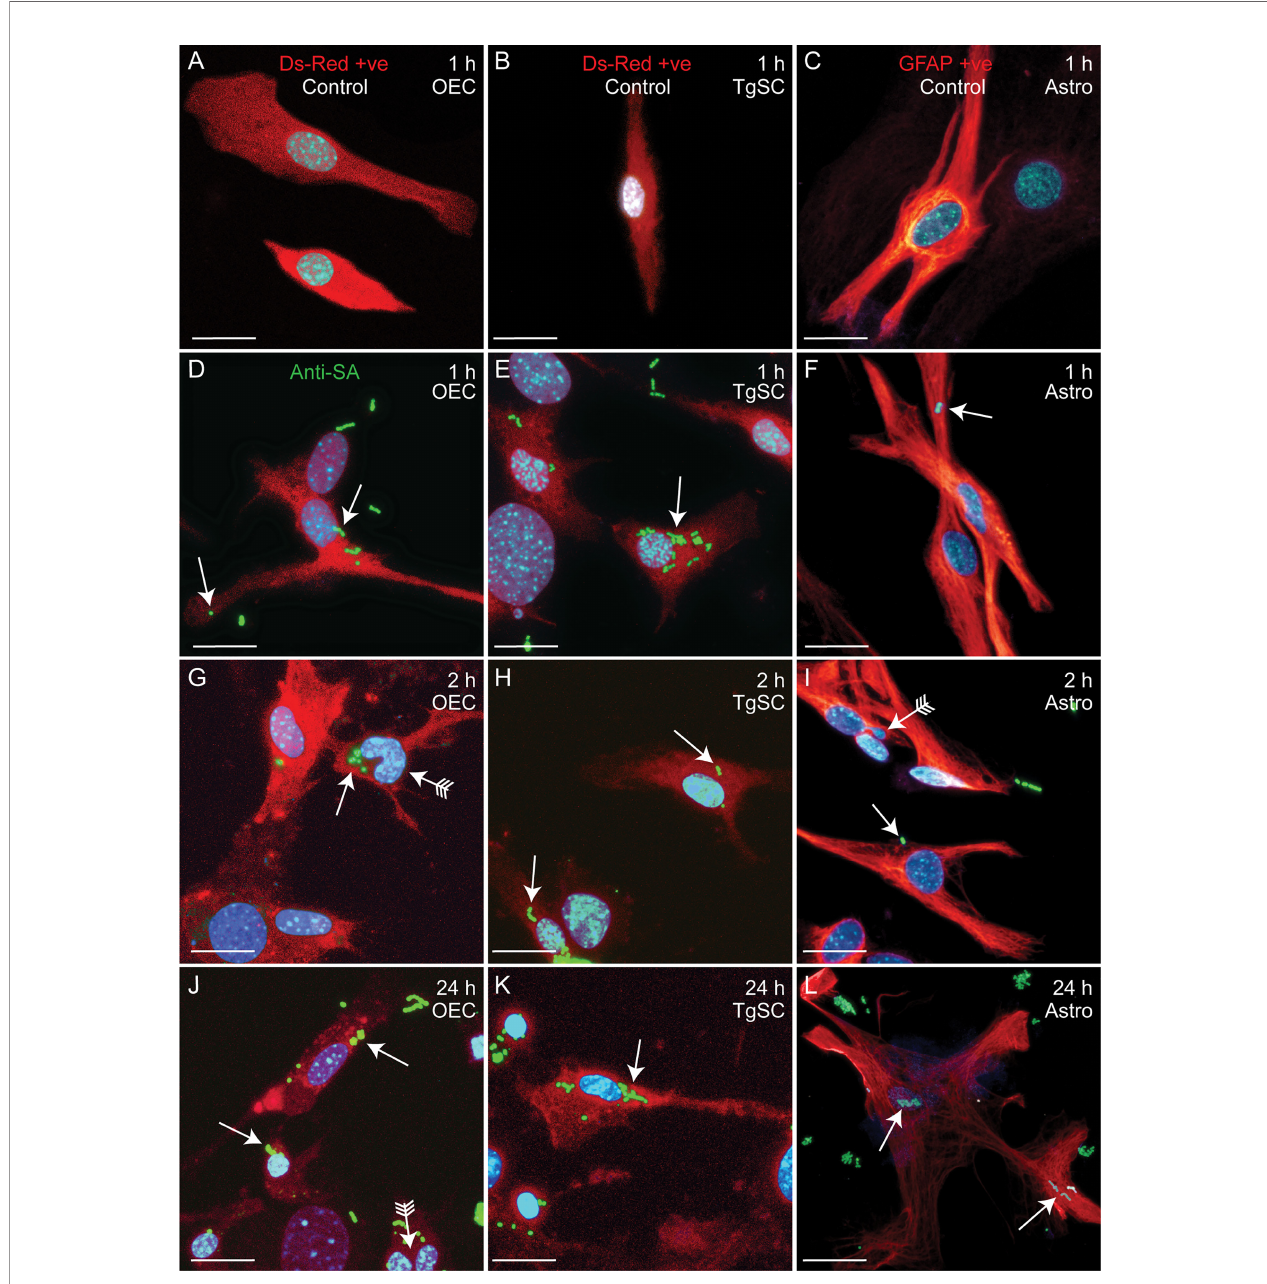
FIGURE 5 | Confocal images showing attachment and internalisation of D cpsE S. agalactiae in the three types of glia. (A – C) Control cells (no S. agalactiae ). Colours and immunolabelling/staining are consistent with Figure 4 (red: glia, blue: nuclei, green: D cpsE ). (D – F) Representative images of OECs, TgSCs and astrocytes 1 h after inoculation with D cpsE (green, arrow). (G – L) D cpsE were detected in glia at 2 h (G – I) and at 24 h post inoculation (J – L) . Some cells exhibited atypical nuclei or binucleation (arrows with tail). Scale bar: 20 m